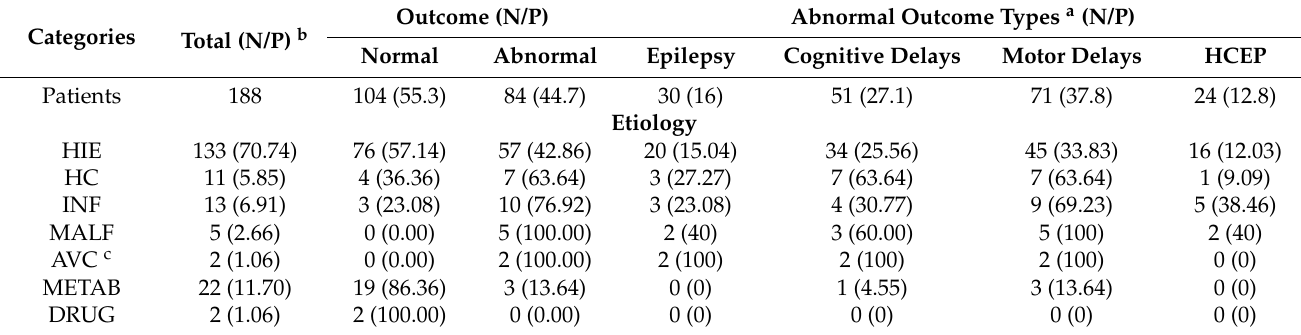
Table 1. Cases distribution based on etiology and abnormal